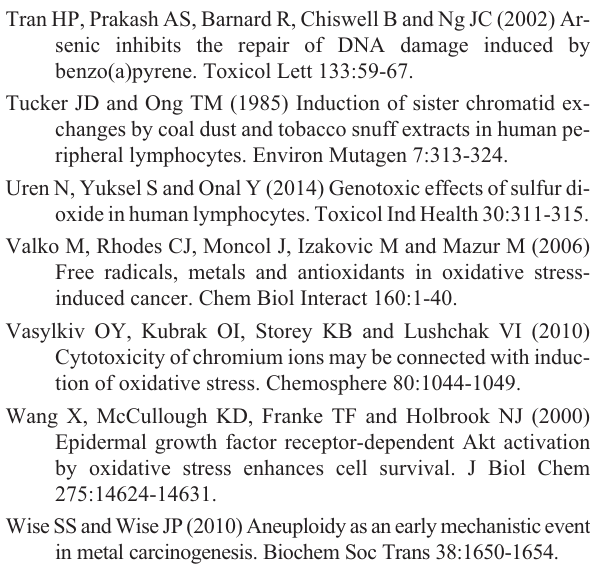
Figure S1 - Coal sample collection sites in Colombia. Figure S2 - Main CPI-PPI network generated by the Cytoscape 3.4.0 program. Table S1 - Major inorganic oxide components in coal ashes (%wt) as identified by XRF. Table S2 - IEs concentrations in coal samples as revealed by Table S3 - Polycyclic aromatic hydrocarbon concentrations